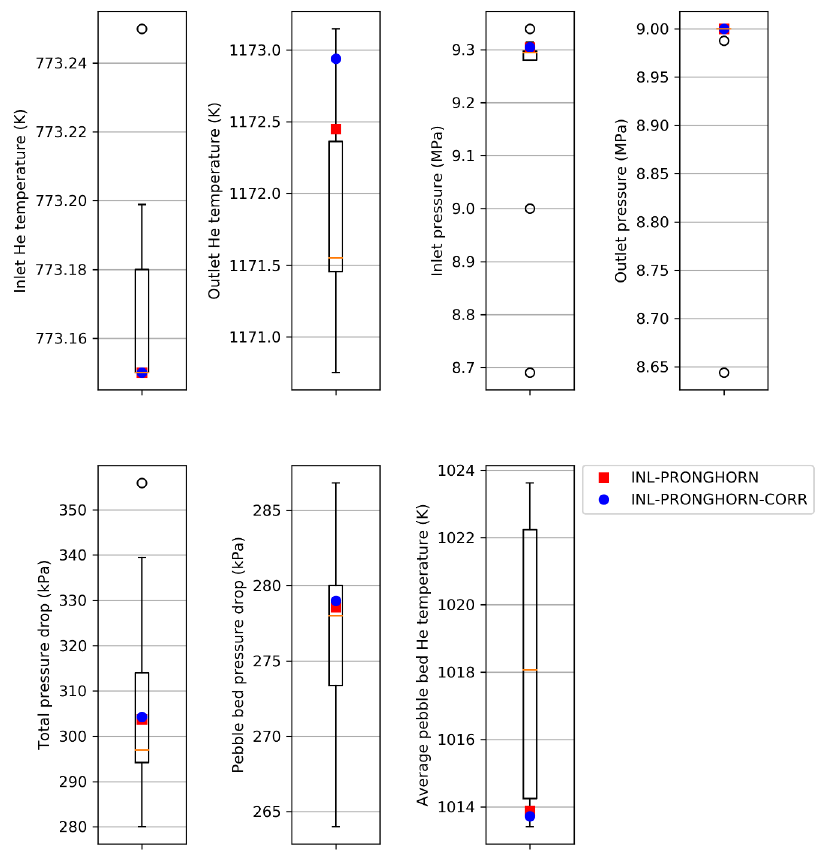
Figure 11: Global Parameter Results Comparison - Inlet He Temperature, Outlet He Temperature, Inlet Pressure, Outlet Pressure, Total Pressure Drop, Pebble Bed Pressure Drop, Average Pebble Bed He